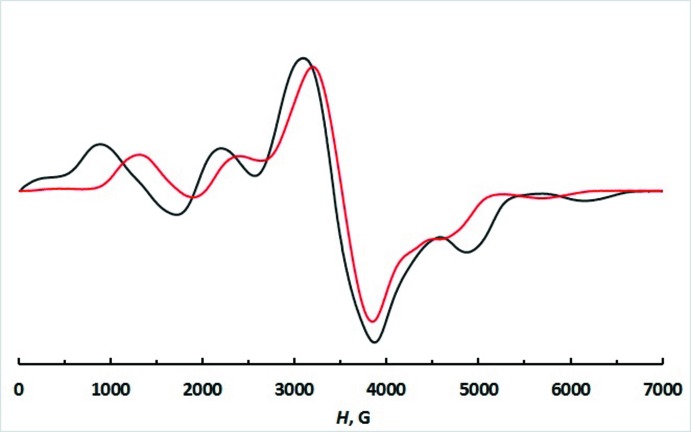
X-band EPR spectra of [L]2[MnCl4] (I) in the solid state at 293 (red) and 77 K (black).